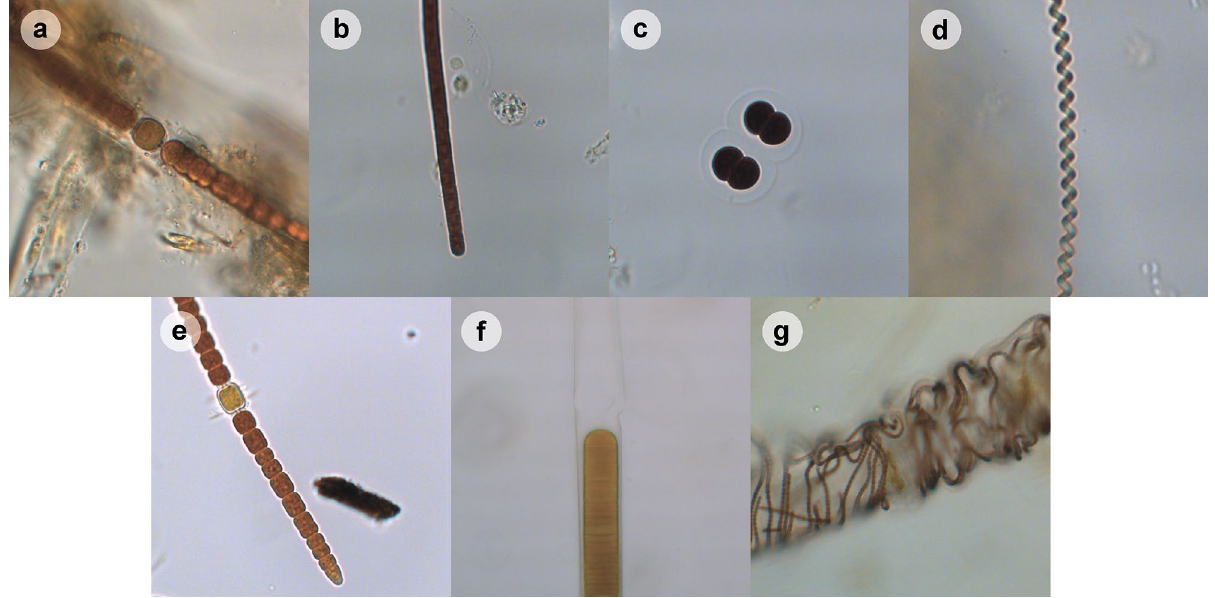
Figure 4. Microscopy images of the most common individual cyanobacterial taxa identified from across the seven BCM-types: ( a ) Calothrix , ( b ) Oscillatoriales , ( c ) Chroococcus cf., ( d ) Spirulina , ( e ) Anabaena cf., ( f ) Lyngbya s.l., ( g ) Heteroleibleinia . All pictures were taken from Lugol’s preserved samples. Photographs a–e are at 630× magnification, and f–g are at 400×